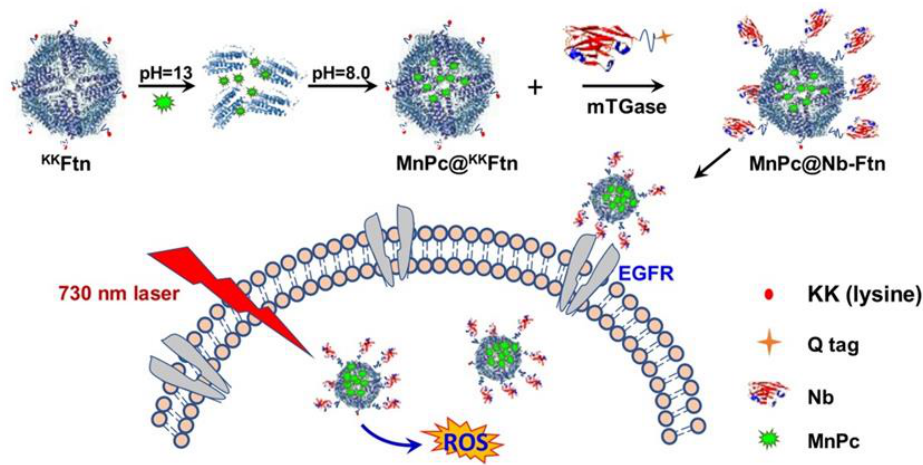
Figure 5. Preparation and targeted delivery of Nb-FTn. Reproduced with permission from ref [44]. Table 1. Surface modification of f erritin. (Please add this sentence “Table should be cited close to where it is first mentioned. Because of the reference order, please leave the table here.” for com-